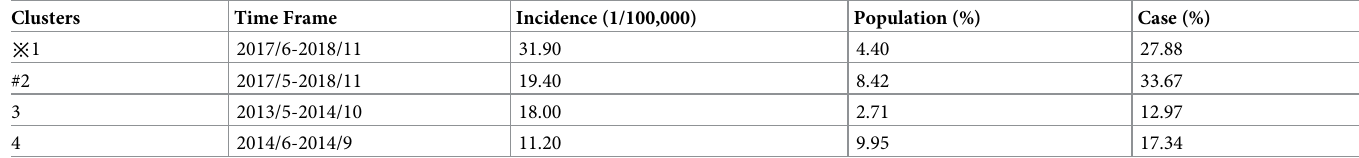
Table 4. Scrub typhus incidence rate, proportion of population and cases in spatiotemporal clusters detected using Kulldorff’s space-time scan statistic in Fujian Province, 2012–2020 � . Clusters Time